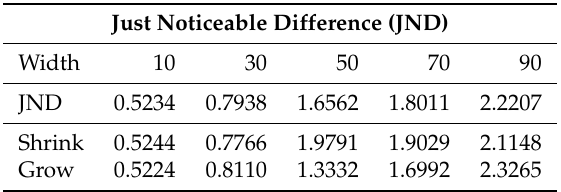
Table 6. Just noticeable difference width in mm for width